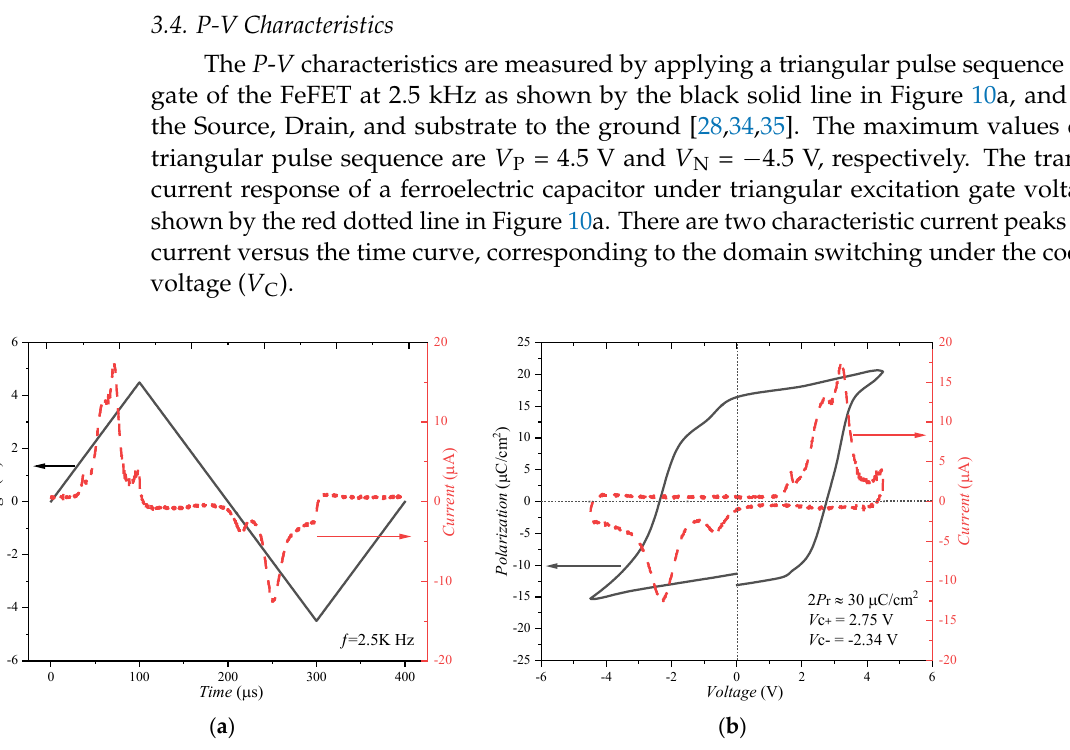
Figure 10. ( a ) Transient current response (red dotted line) of the FeFET under triangular excitation gate voltage (black solid line) during polarization measurements at a frequency of 2.5 kHz, and ( b ) resulting Current–Voltage (red dotted line) and Polarization–Voltage (black solid line) curve. The polarization measurement is actually a measurement of charge in the capacitor given by Equation (1) [34,36].